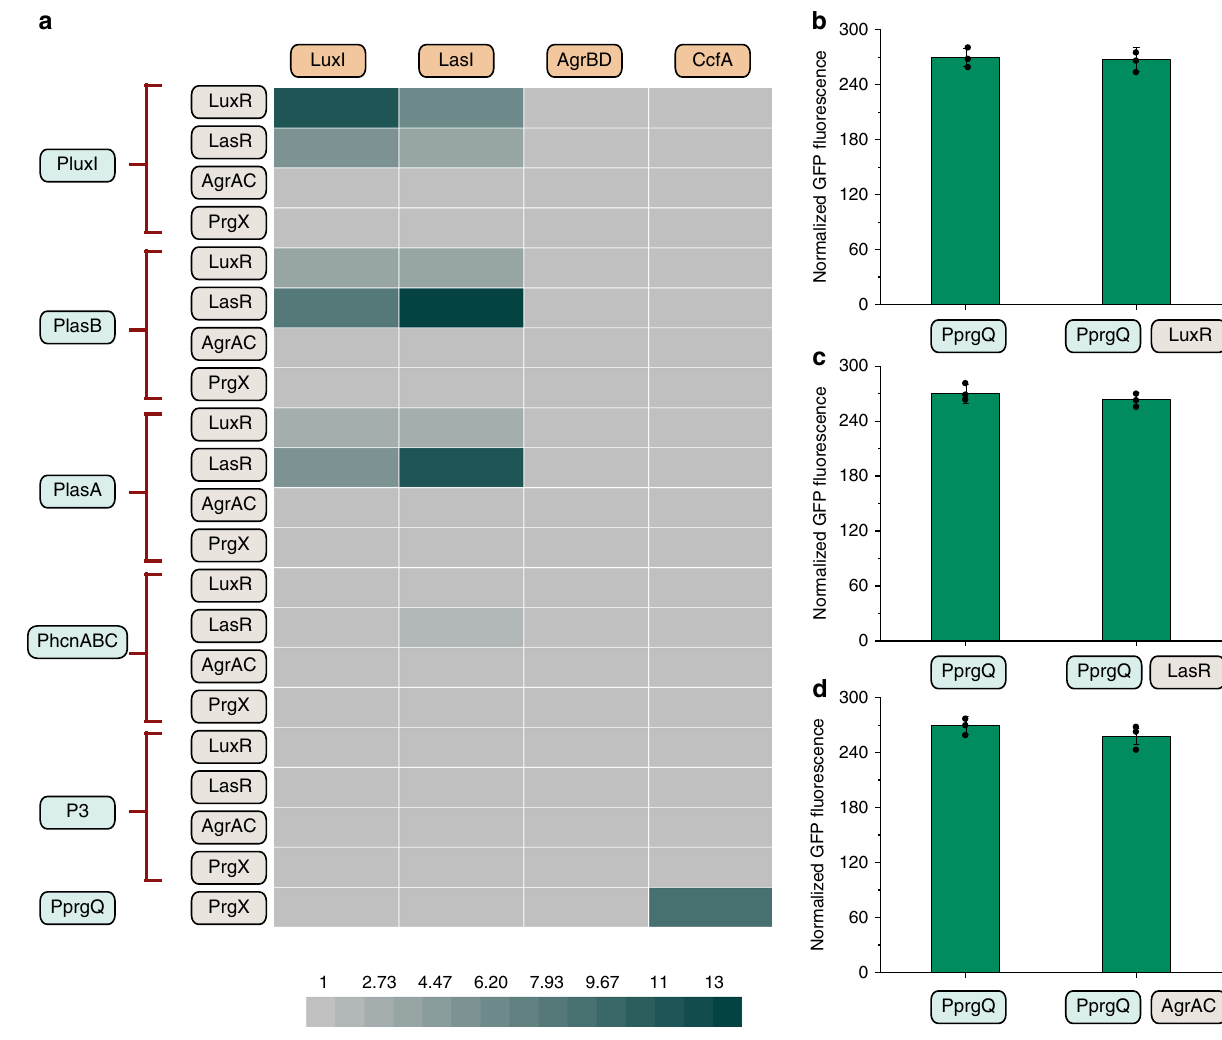
Fig. 2 Investigating cross-interactions between different QS systems. a Heat map of induction ratio from 84 combinations of different QS components. All possible 84 response promoter/signal inducer/actuator combinations were created. The induction ratio was de fi ned as dividing the normalized GFP fl uorescence from different combinations by the control strain harboring only response promoter and two corresponding empty plasmids. b Evaluating cross-talk between response promoter from E. faecalis (PprgQ) and regulator LuxR. c Evaluating cross-talk between response promoter from E. faecalis (PprgQ) and regulator LasR. d Evaluating cross-talk between response promoter from E. faecalis (PprgQ) and regulator AgrAC. Each QS component was expressed by constitutive trc promoter. Pre-cultured recombinant strains were grown in 25 mL of MOPS medium at 30 °C with 220 rpm orbital shaking. Cell fl uorescence and cell density (OD 600 ) were measured after 30 h of culture on a Cytation 3 imaging reader system (BioTek, Winooski, USA). All fl uorescence measurements were normalized by dividing measured fl uorescence values by the OD 600 of that well to conduct a per-cell measurement. Values are shown as mean ± SD ( n = 3 biological replicates). Source data are available in the Source data fi